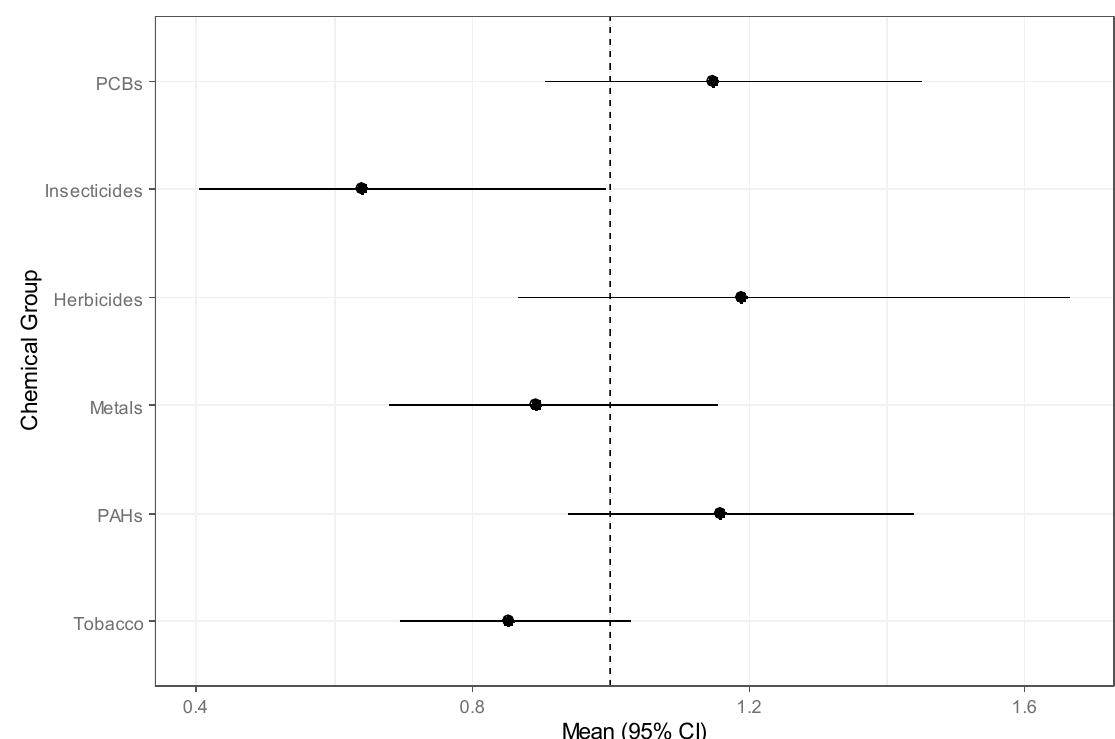
Figure 1. Forest plot of odds ratios and 95% credible intervals for chemical groups for childhood leukemia from the Bayesian group index model with a line at the null value of 1.0.